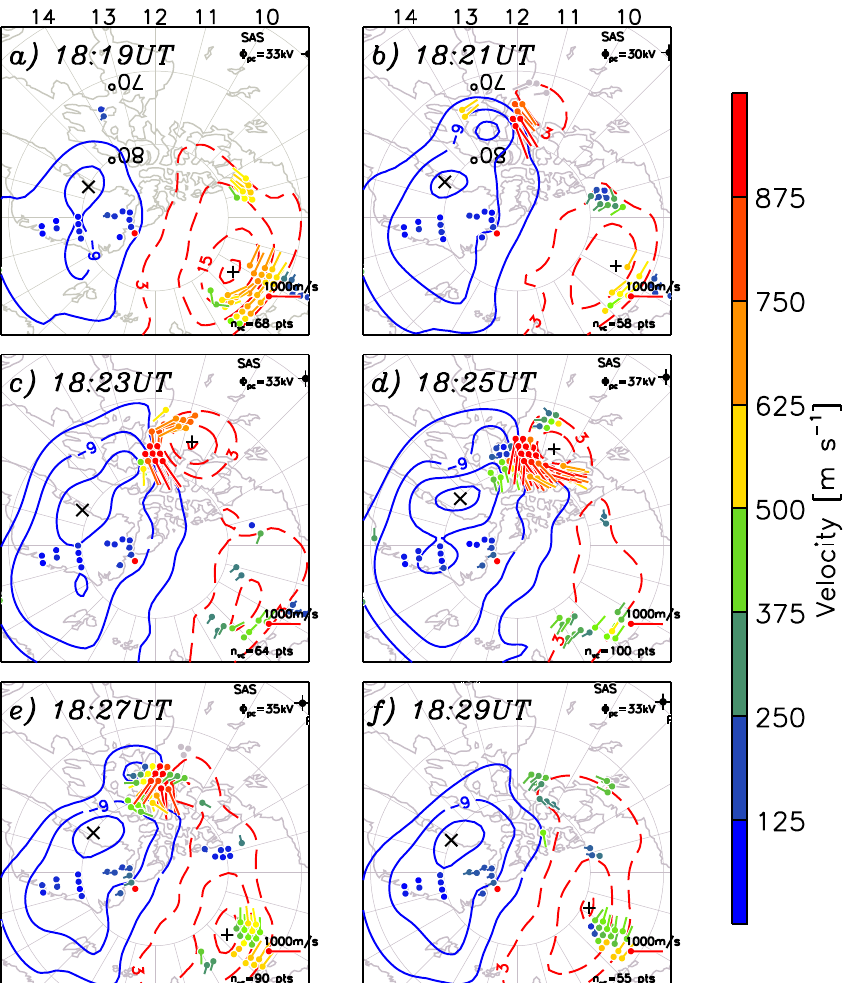
Fig. 8. Ionospheric convection pattern fitted into the SuperDARN measurements. The maps are in magnetic coordinates and the Sun is to the top, dawn to the right, and dusk to the left in each panel. The maps represent the flow pattern with 2-min integration time at (a) 18:18– 18:20, (b) 18:20–18:22, (c) 18:22–18:24, (d) 18:24–18:26, (e) 18:26–18:28 and (f) 18:28–18:30UT. During an otherwise quiet period and positive IMF B Z , a short-lived channel of fast flow up to 1000ms − 1 (red vectors) was observed on the dayside following the fast flows in the magnetosheath.